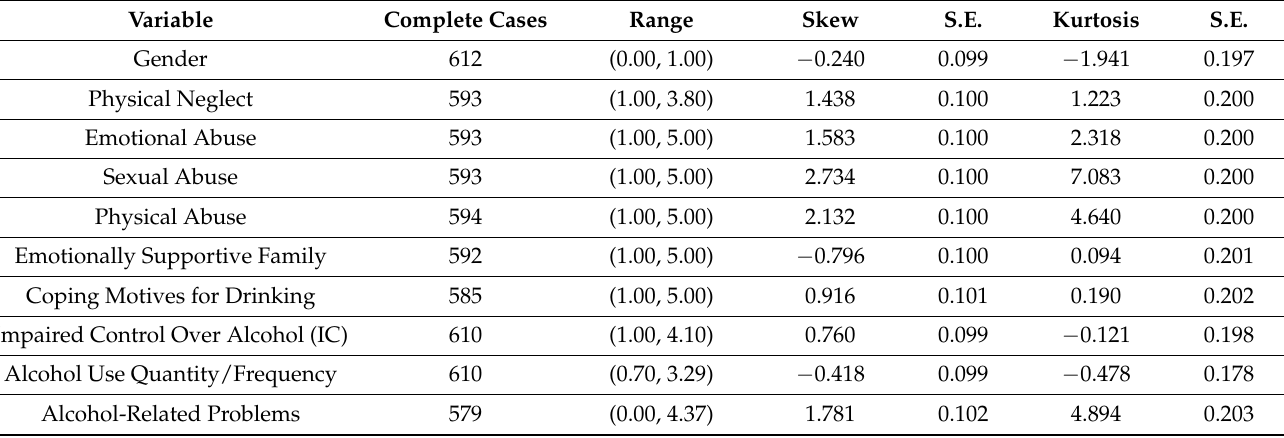
Table 2. Variable name, number of complete cases out of 612, range of responses, skew, skew standard error, kurtosis, kurtosis standard